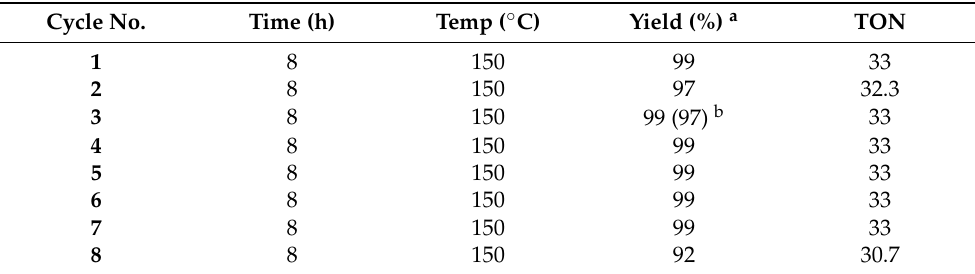
Table 10. Recycling results of 2b -catalyzed Suzuki-Miyaura reaction of aryl boronic acid ( 11 ) with 4-cyanobromobenzene ( 16 ) under the thermomorphic